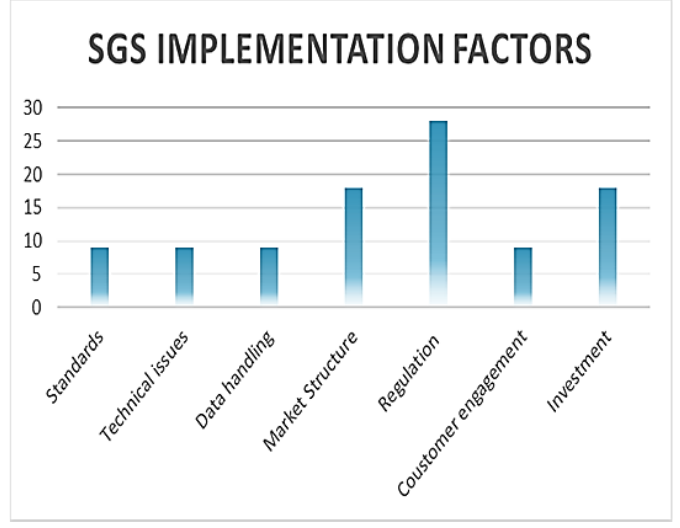
Figure 10. Factors that affect the implementation process of SGS.